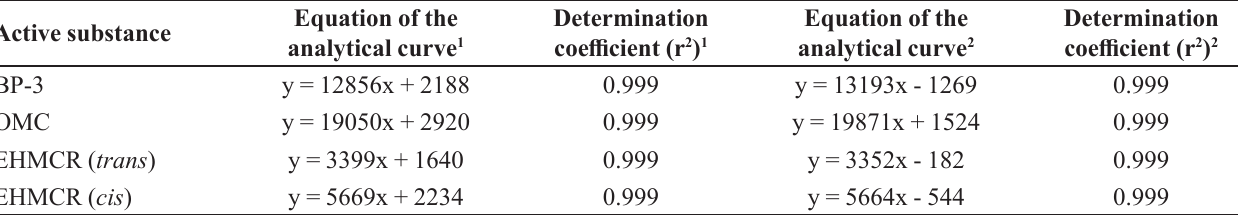
TABLE III - Equations of the analytical curves, y = ax + b, and determination coefficients (r 2 ) Active